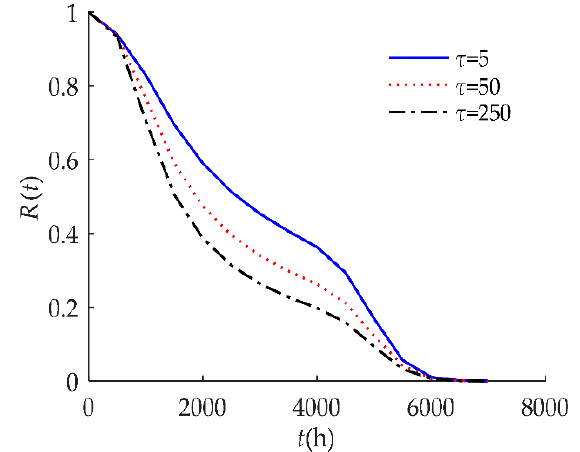
Figure 4. Sensitivity analysis of R ( t ) on τ for example I.